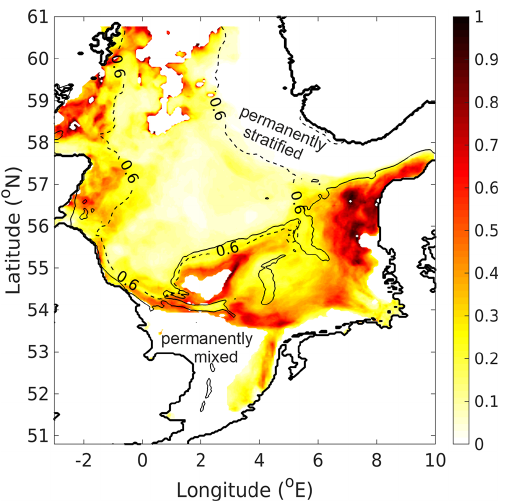
Figure 10. Ratio between the number of days when the water is stratified and the number of days when the air temperature inten- sively increases. The dashed contour line with a value of 0.6 in- dicates the area with a correlation coefficient R = 0 . 6 between the air temperature and the potential energy anomaly for the multiyear mean of the summertime. The thin solid line indicates the 50m iso-